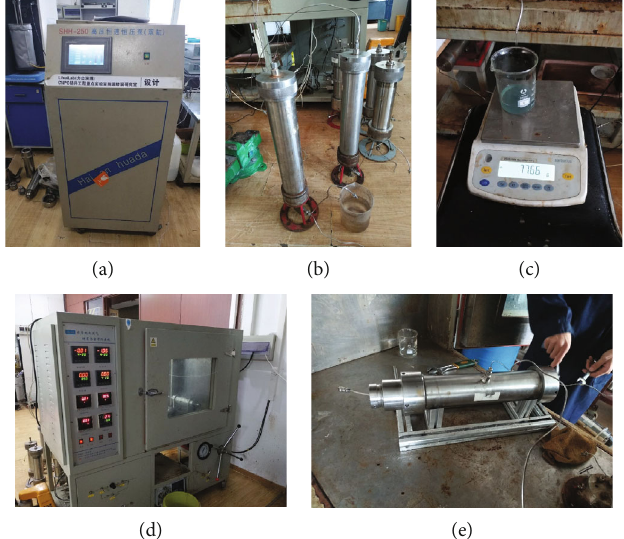
Figure 2: Unconventional natural gas reservoir damage evaluation equipment. (a) Constant- fl ux pump. (b) Intermediate container. (c) Electronic balance. (d) Con fi ning pressure control device. (e) The core